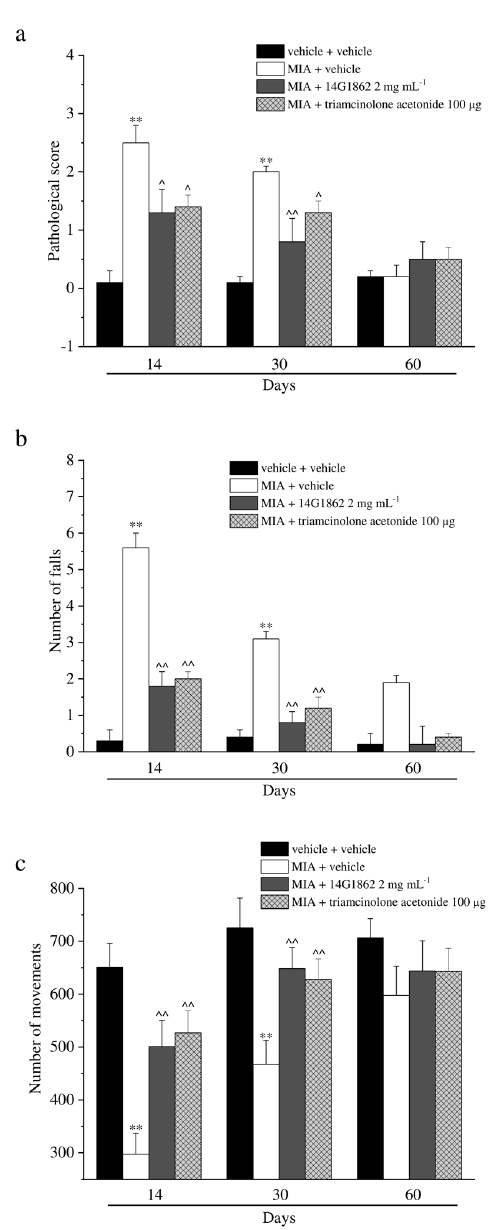
Figure 3. Articular pain, behavioural measurements related to motor alterations. Monoarthritis was induced by MIA (2 mg/25 μ L) injection into the tibio-tarsal joint on day 7. Twenty μ L of 14G1862 (2 mg mL − 1) or triamcinolone acetonide 100 μ g were i.a. administered 7 days after MIA (day 1). Behavioural measurements were performed on days 14, 30 and 60 after osteoarthritis induction. ( a ) Effect of i.a. injection of 14G1862 in the rat, measure of motor abilities related to pain (Beam balance test); ( b ) Effect of i.a. injection of 14G1862 in the rat, measure of number of falls in 10 min (Rota rod test); ( c ) Effect of i.a. injection of 14G1862 in the rat, measure of number of movements (Animex test). Each value represents the mean ± S.E.M. of 6 rats per group, performed in 2 different experimental sets. ** p < 0.01 vs. vehicle + vehicle; ^ p < 0.05 and ^^ p < 0.01 vs. MIA + vehicle.